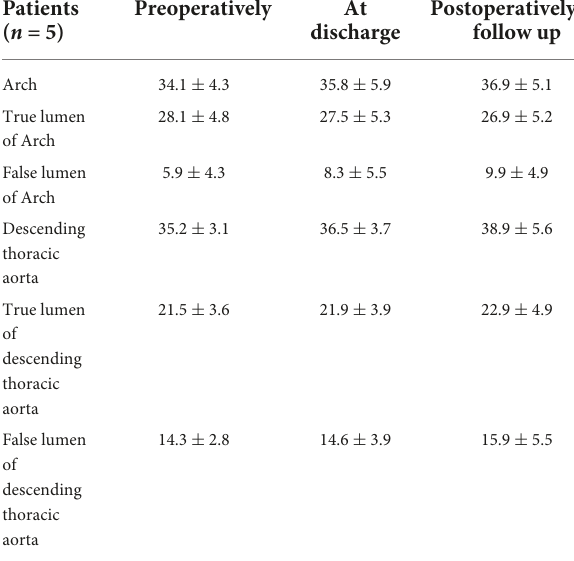
TABLE 4 Details of the aorta of patients with patent false lumen of aortic